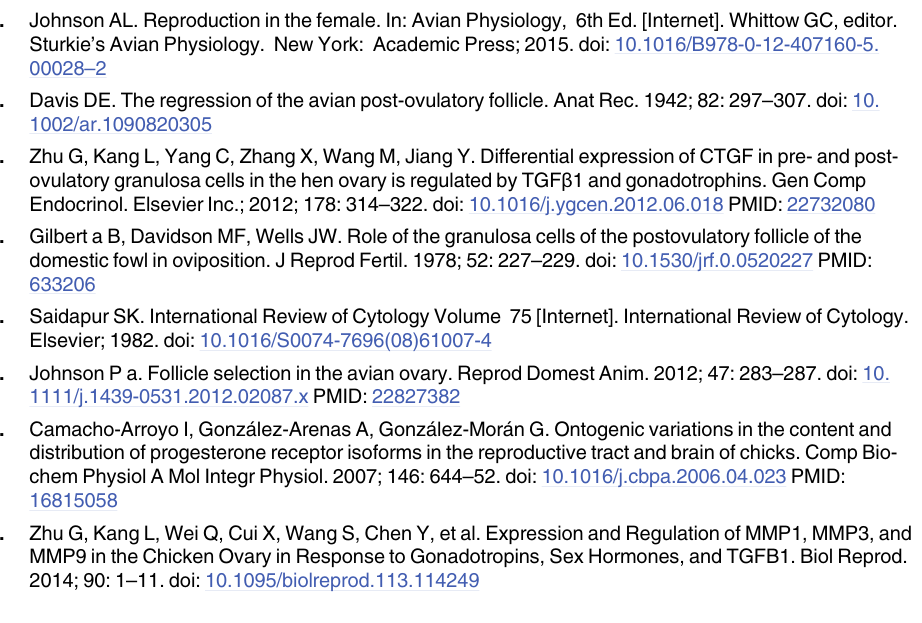
S1 Fig. Map of the Star, Cyp11a1 and Hsd3b proximal promoters and CpG sites. Individual CpG sites were underlined with solid line and numbered. Arrows indicate the primer binding sites for the PCR amplicons. The putative transcription start site was denoted as +1. The star codon is in red. S1 Table. Primers used in this study. S2 Table. Raw data of RNA-seq analysis. S3 Table. The differentially expressed genes in SWF vs F1 and F1 vs POF1 follicles. S4 Table. Gene Ontological classification of differentially expressed